Question: Looking at the figure, what chart type is it?
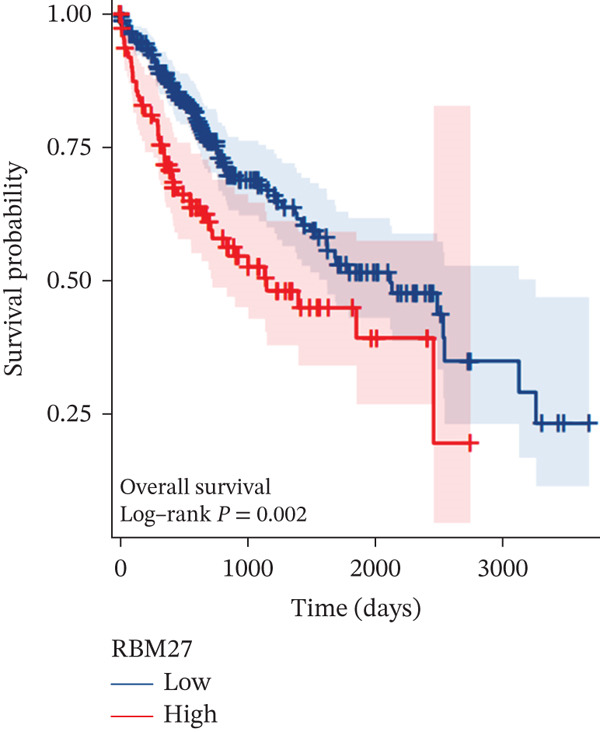
Answer: survival